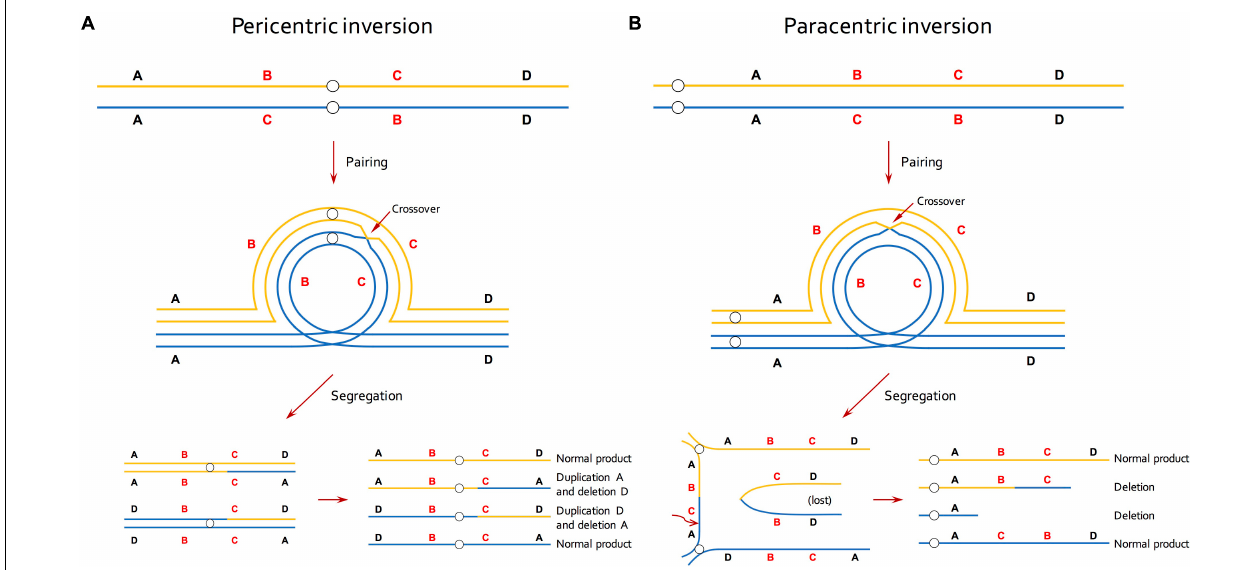
FIGURE 1 | Effective reduction in recombination of inversion by selection against recombinant gametes in meiosis. (A) In individuals that are heterozygous for a pericentric inversion, a single crossover within the inversion generates unbalanced gametes that contain a duplication and a deletion. (B) In individuals that are heterozygous for a paracentric inversion, a single crossover within the inversion produces a dicentric bridge and an acentric fragment. The acentric fragment is lost because it cannot be drawn to either end and the chromosomal bridge breaks at random point during segregation, resulting in two deletion products. Lines of blue and orange colors represent homologous chromosomes and small circles indicate